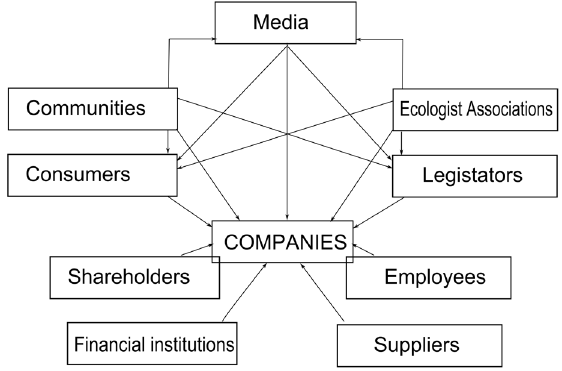
Figure 2. Environmental Stakeholders. Source: Garce´s [36].